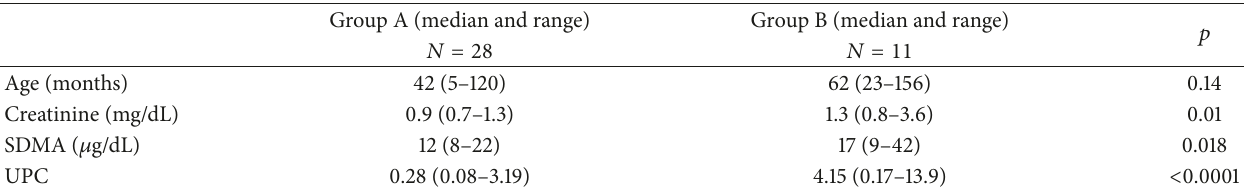
Table 1: Comparison of age, creatinine, and SDMA concentrations and UPC on the day of diagnosis of leishmaniosis for Group A versus Group B dogs.